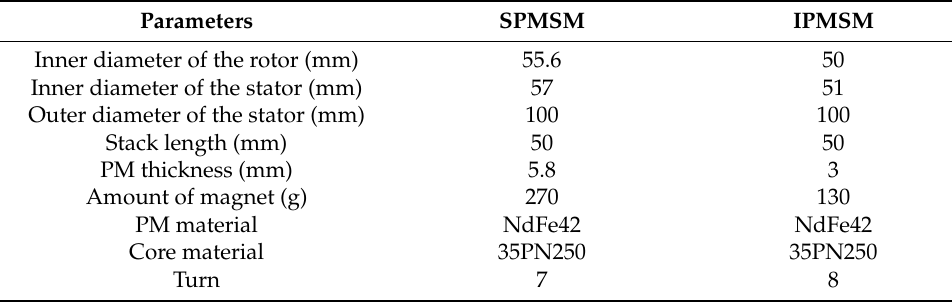
Table 2. Analysis model specifications.